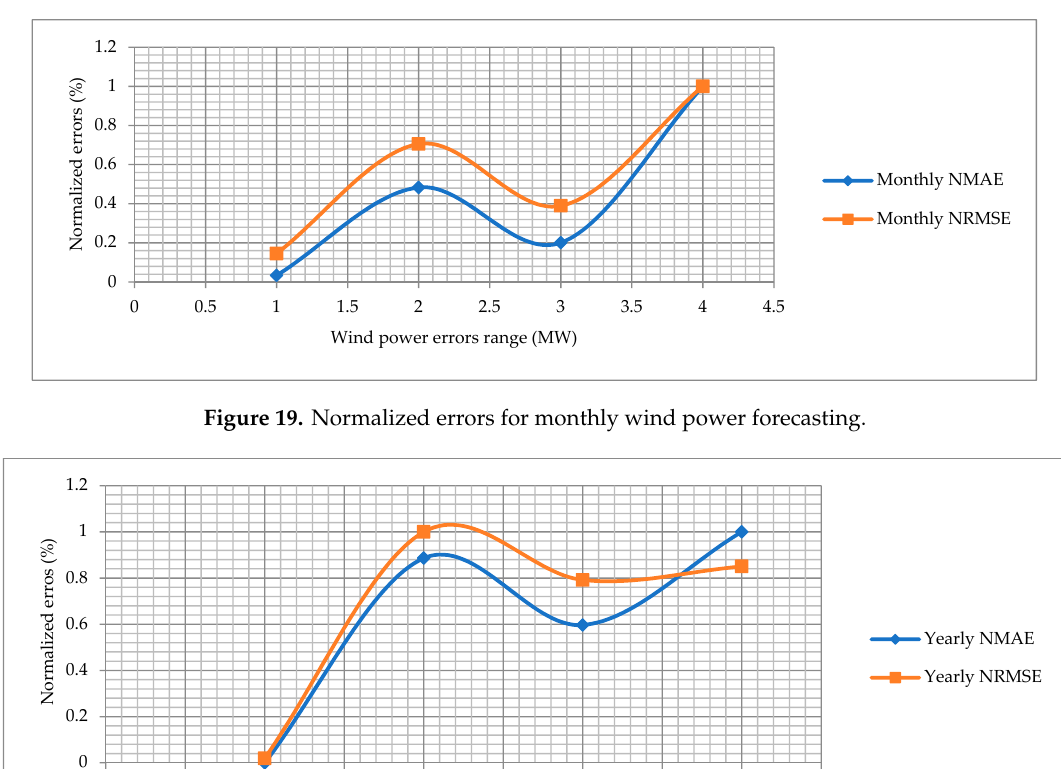
Figure 18. Normalized errors for hourly wind power forecasting.